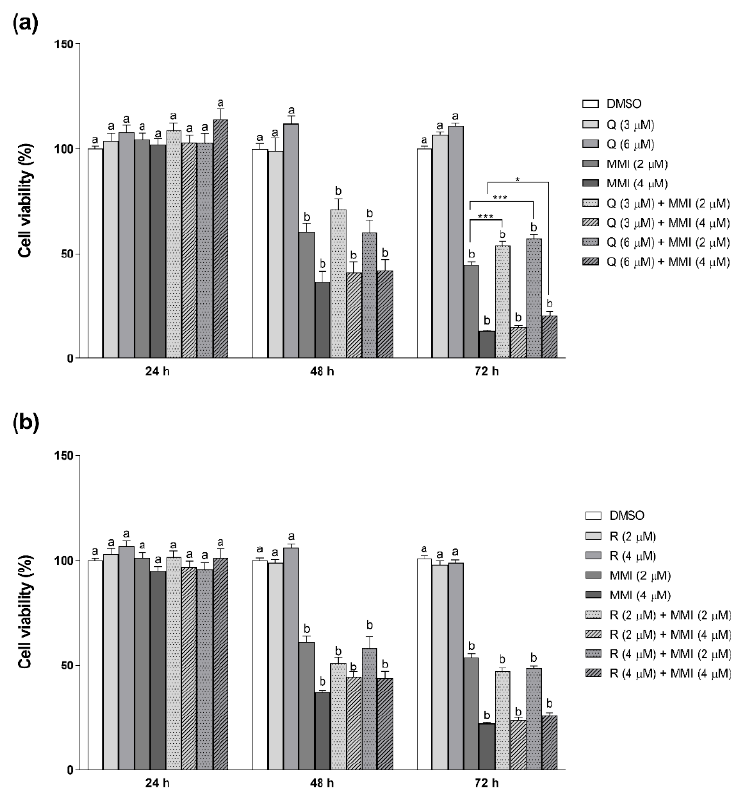
Figure 2. Effects of Q ( a ) and R ( b ) against MMI-induced toxicity in CRFK cells, measured with an NRU assay. Cells were exposed to MMI (2 and 4 µM) in the presence or absence of either Q (3 and 6 µM) or R (2 and 4 µM) for 24, 48, and 72 h. Results are expressed as a percentage of viability compared with the solvent control (0.1% DMSO). Data are represented as mean ± SEM of three independent experiments and analyzed by one-way ANOVA followed by Sidak’s test. Different letters indicate statistical differences compared with control cells ( p < 0.05 or less). Statistical differences with respect to the cells treated with MMI alone are reported (* p < 0.05, *** p < 0.001).